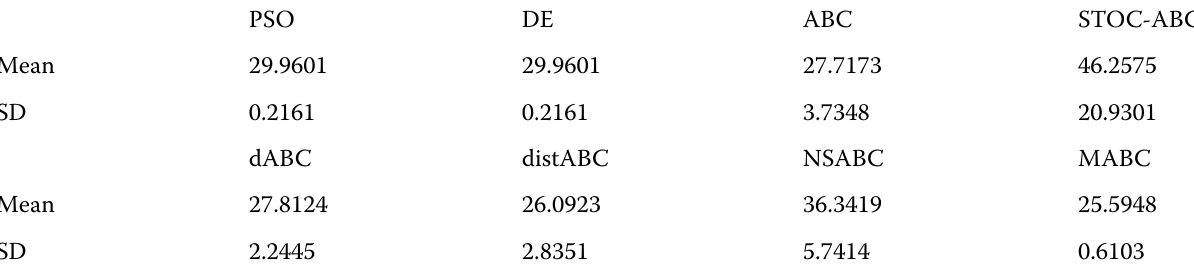
Table 12 Experimental results on parameter estimation for frequency-modulated sound waves PSO DE